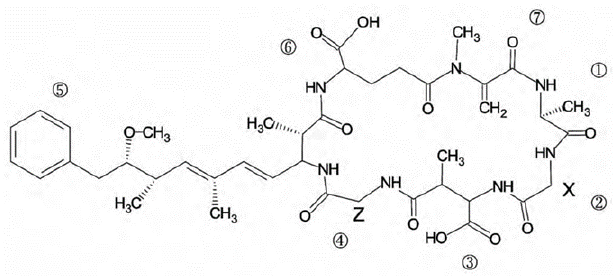
Figure 1. Chemical structure of microcystins (MCs). X and Z are variable L -amino acids [5].